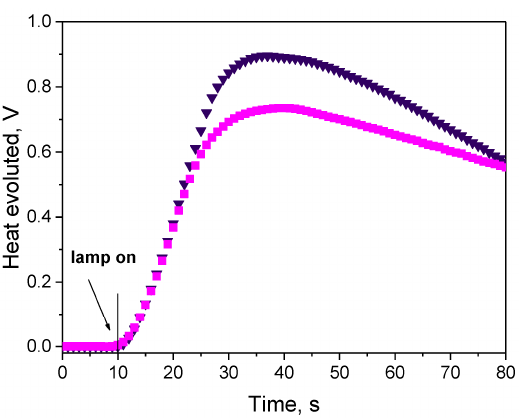
Figure 40. Comparison of the photo-initiating ability of AN6 and camphorquinone (CQ) using same co-initiator, (3,4-dimethoxyphenylthio)acetic acid (diMPhTAA). Reprinted from Ref. [223], Copyright 2021, MDPI.